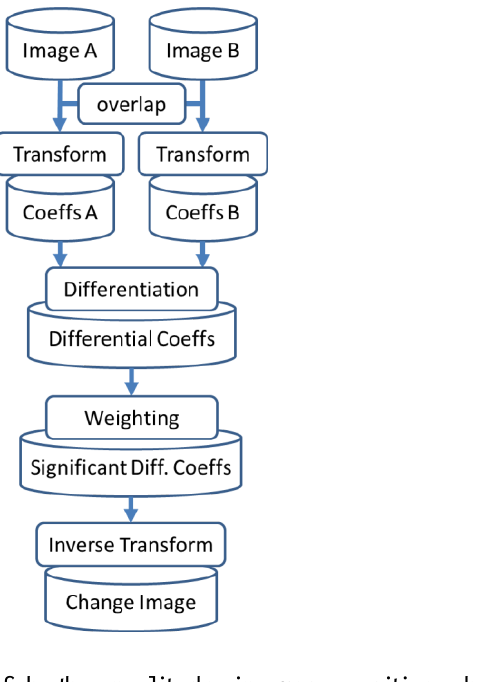
Figure 12. Color composition of both amplitude images, positive changes appear in orange, negative changes appear in